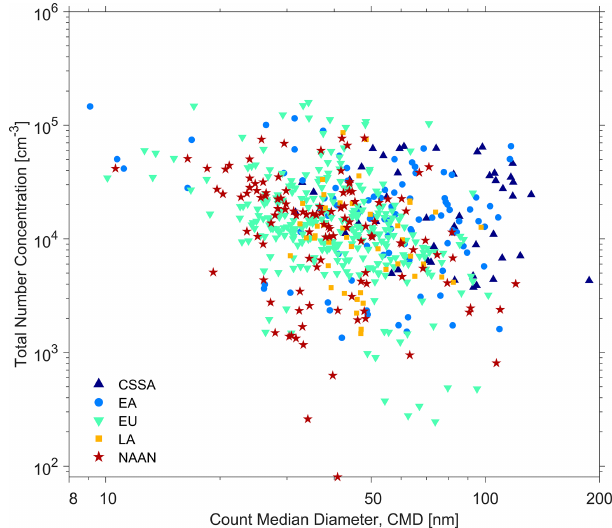
Figure 8. Relationship between the total particle number concen- tration, integrated over the measured size range, and the count me- dian diameter (CMD), determined for each submicron number PSD measured by electrical mobility-based techniques (624 PSDs) and grouped by geographical